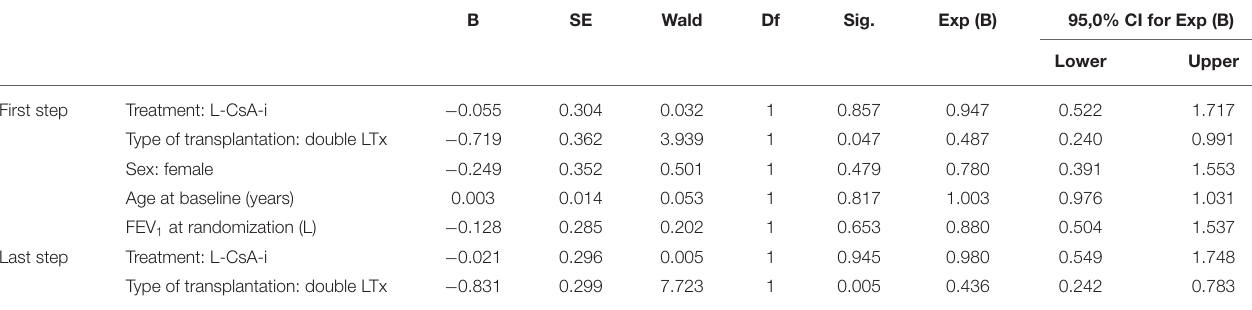
TABLE 4 | Cox regression model with all-cause mortality as the dependent variable and parameter estimates for covariates in the final equation. B SE Wald Df Sig.